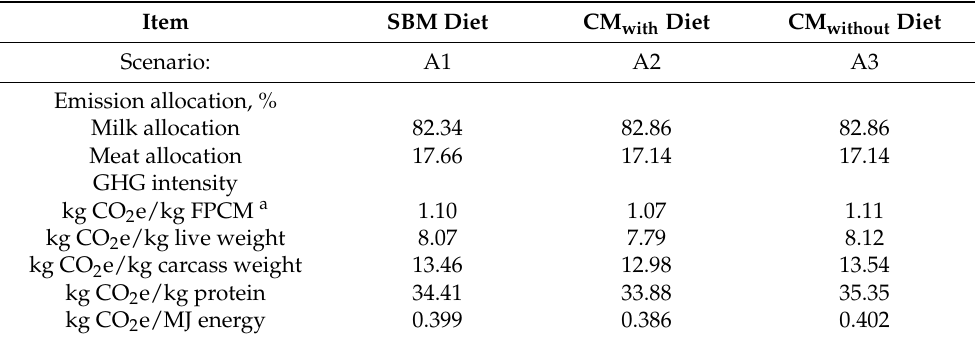
Table 8. Greenhouse gas emission intensity of milk and meat produced by a dairy farm in Alberta using canola meal, with (CM with ) and without (CM without ) enteric methane mitigating effect, in the diets of the lactating